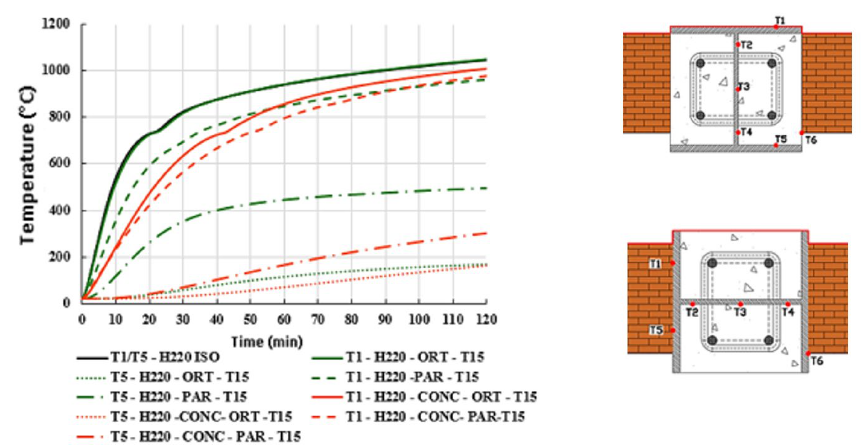
Figure 12. Curve for temperature versus time for columns